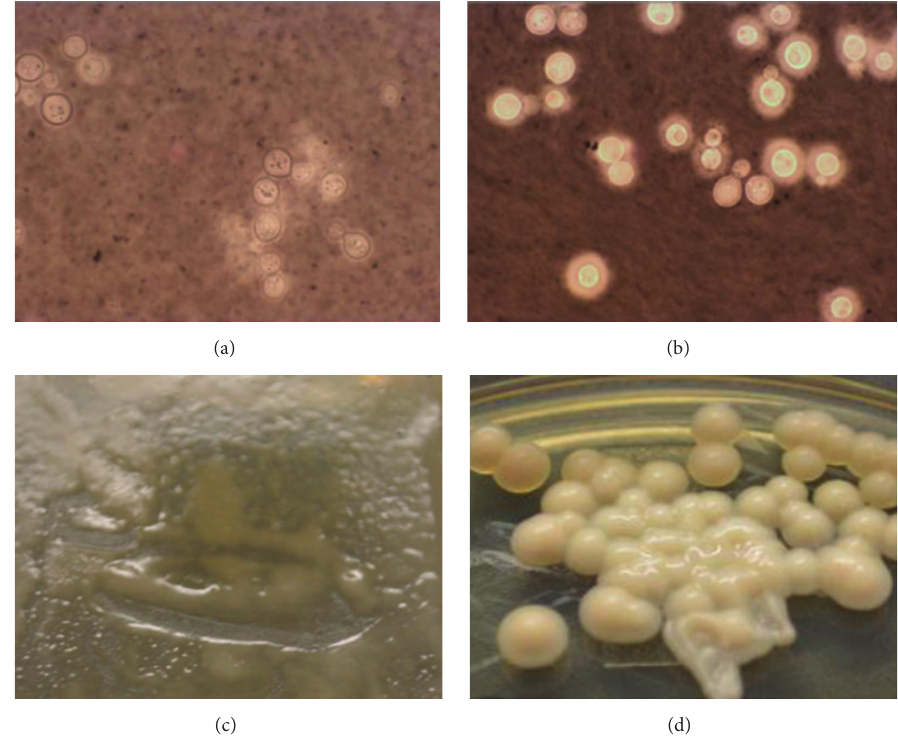
Figure 2: (a and b) India ink of original uncapsulated colony (a) and subbed colony (b) which produced capsule (1000x magnification). (c and d) Original colony on SABs flask; note rough colony phenotype as well as small colony formation (c). Subbed colonies, note abundant capsule production and typical large colony formation